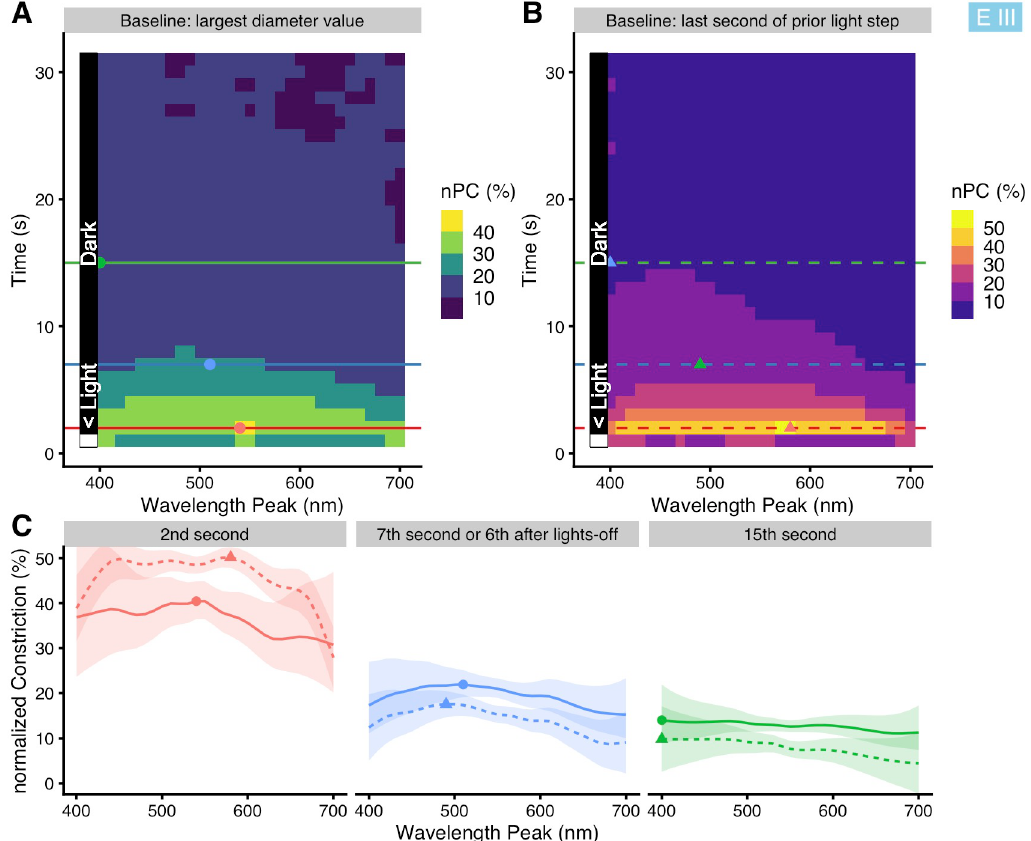
Fig 9. Interaction of wavelength with time in Experiment III , for protocols Short 1 and Short 2 . Time is the time (in seconds) since light onset or light change to the respective wavelength. (A) False-color graph of model predictions for the nPC’s dependence on wavelength (x-axis) and time (y-axis). All other predictors (basic model) are held constant at their average. Horizontal lines show where the respective traces shown in part (C) are taken from, and points mark the wavelengths of the respective maximum nPC value of these traces. (B) Like (A), but with a different measure of nPC where the nPC baseline is taken as the mean pupil diameter across the last second of the respective previous light step. Model diagnostics are superior to those for the Model in part (A). (C) Model predictions for the nPC vs. wavelength at three points in time after light-step onset: in the 2 nd second (red traces), the 7 th second (green traces), and the 15 th second (blue traces); the latter two cases are also the 6-second PIPR and 14-second PIPR, respectively. Ribbons show the 95% confidence interval for the predicted means. Dotted lines with a triangle represent the scaling according to (B), full lines with a filled circle according to (A).